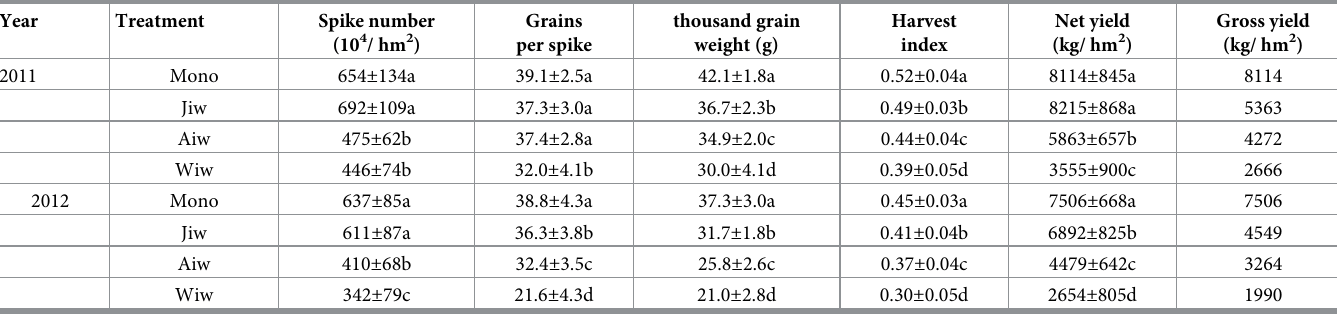
Table 2. Yield components of wheat in monoculture configurations and 3 different fruit tree-wheat intercropping systems in 2011 and 2012. Year